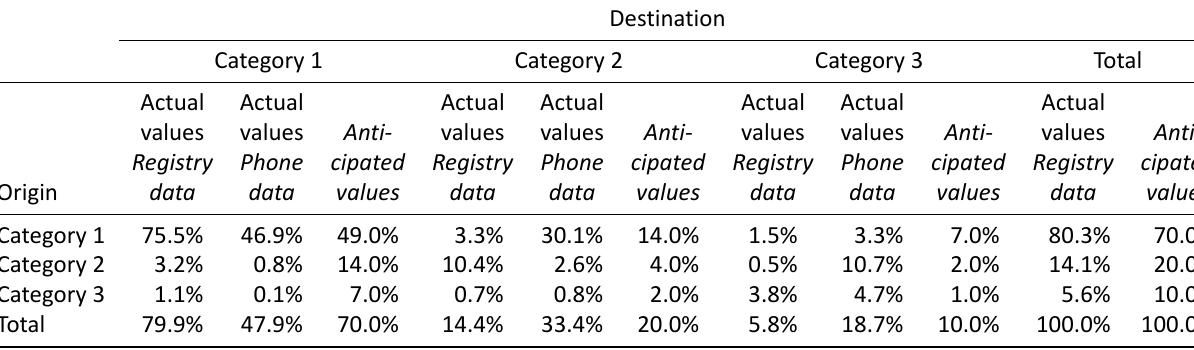
Table 3. Flows across area categories